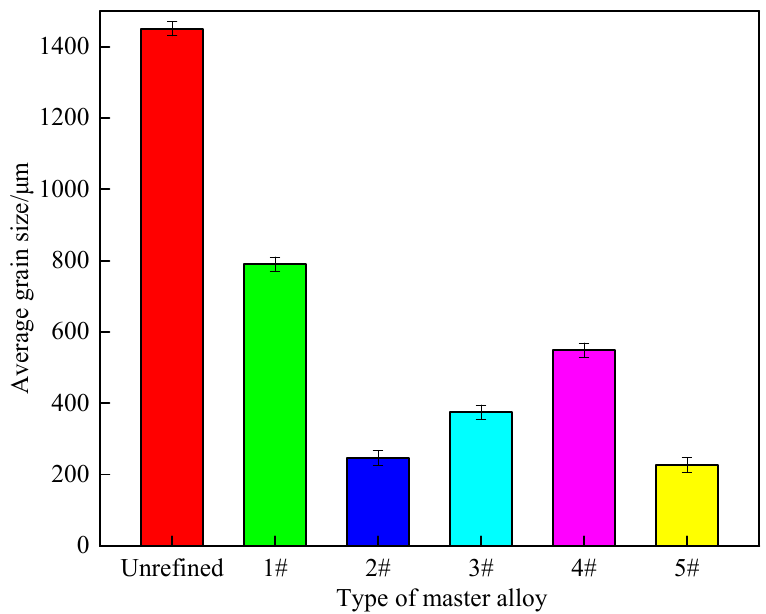
Figure 13. Average grain size of the refining samples in Figure 12.